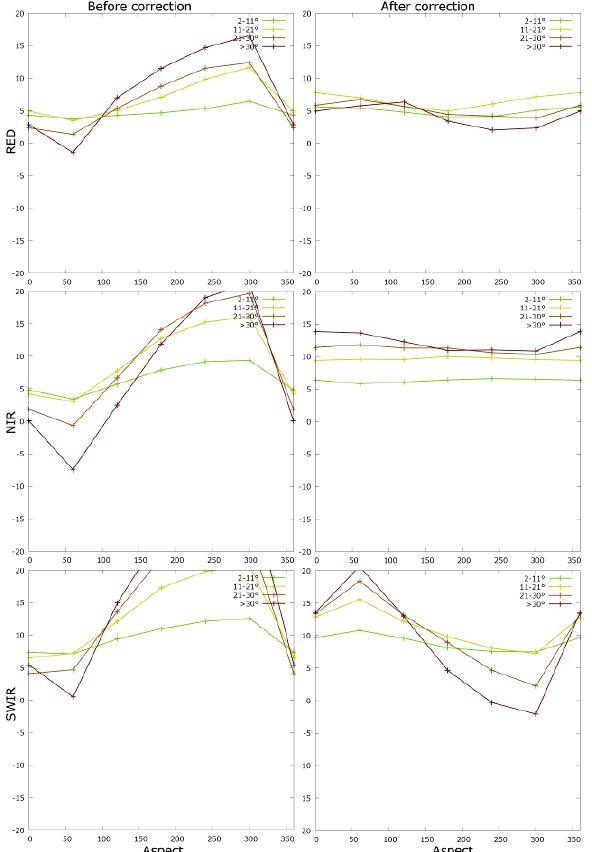
Figure 4. Relative errors between mean reflectance in lowlands (0-2° slope) and mean hillside reflectance for different slope ranges (colour curves) plotted against aspect for 3 spectral bands of Landsat 8 and broad-leaf forest land cover class. Curves show successful retrieval of reflectance values for all aspect values in red and NIR band. SWIR curves show turnover effect for higher slope